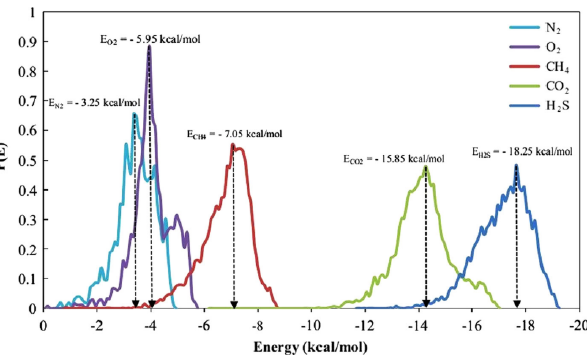
Figure 19. The adsorption energy distribution of CO 2 , CH 4 , O 2 , N 2 and H 2 S gas molecules ( P = 0~10 bar, T = 298 K) [48].